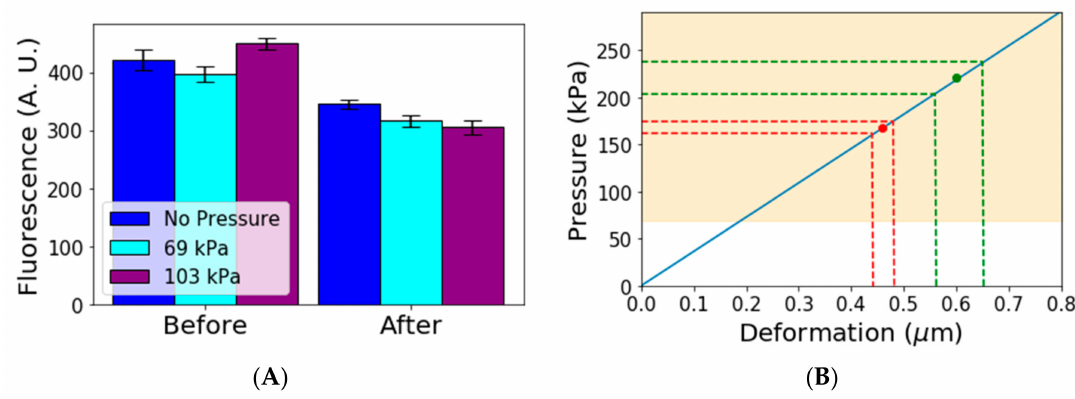
Figure 3. ( A ) Gene expression under different pressure conditions. Bars show average gene expression. Bars on the left show the average gene expression before starting the experiment. Bars on the right show the average gene expression after 4 h for three different pressure conditions. Error bars show 95% confidence intervals ( B ) Blue line shows a simple elastic model relating the deformation to the pressure. The green and red dots represent average deformations and estimated pressure in two other devices [16,21]. The green and red dotted lines show confidence intervals for deformation and pressure. The yellow area represents the region in which we have observed that pressure affects gene